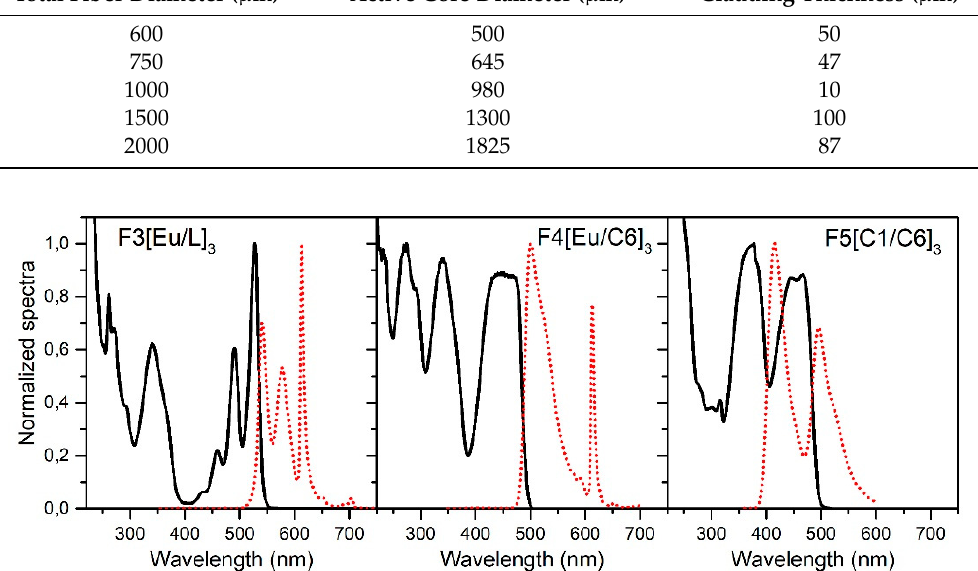
Figure 1. Total absorption and emission bands of the selected hybrid combinations of dopants measured in DCM dissolution. Solid line: absorption. Dotted line: emission.